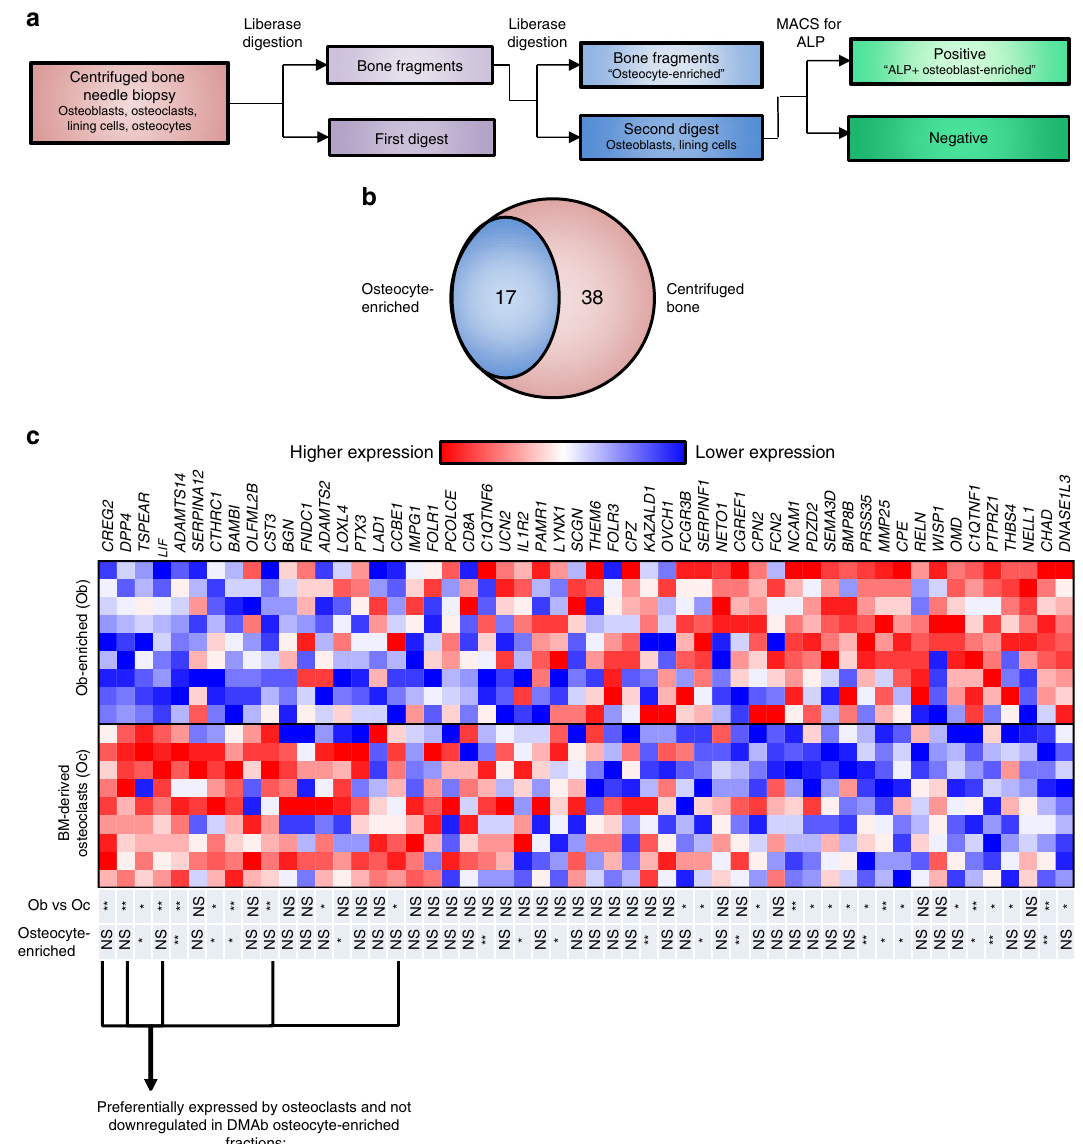
Fig. 3 Identi fi cation of osteoclast-derived secreted factors involved in coupling. a Flow chart describing processing of the bone biopsy samples to select for osteocyte- and osteoblast-enriched fractions. b Overlap of DMAb-suppressed secreted factor genes in centrifuged bone vs. the osteocyte-enriched fraction ( N = 15 participant biopsies/group). For both sample sets, differential gene expression was determined using the R package edgeR. Ingenuity Pathway Analysis was used to identify differentially expressed secreted genes. c Heat map comparison of gene expression in osteoblast-enriched vs. bone marrow-derived osteoclast cultures. Red denotes higher expression and blue denotes lower expression. The Wilcoxon ’ s signed-rank test was used to determine signi fi cance between osteoblast-enriched (Ob) and bone marrow-derived osteoclast (Oc) gene expression. * P < 0.05; ** p < 0.01; NS not signi fi cant. Signi fi cance between osteoblast-enriched (Ob) and osteoclast (Oc) gene expression is shown in the Ob vs. Oc column ( N = 9 participant samples/group). Signi fi cant change in osteocyte gene expression by DMAb compared to placebo is shown in the osteocyte-enriched column ( N = 15 participant biopsies/group); differential expression of RNA-sequencing osteocyte data was performed with the R program edgeR. Source data are provided as a Source Data fi 12 months ( p = 0.07, p = 0.14, respectively; ANCOVA and D-alone group ( p < 0.01; ANCOVA and Bonferonni) over Bonferonni), the decrease was numerically greater in the DMAb 12 months. The change in BMI did not differ in the bispho- group (Fig. 5b). The change in BMI differed among the three sphonate group and the calcium and vitamin D-alone group over groups both over the fi rst 6 months ( p < 0.05) and over 12 months the fi rst 6 months ( p = 0.09) or over 12 months ( p = 0.16; ( p < 0.001, Fig. 5c; ANCOVA and Bonferonni). This was due to a ANCOVA and Bonferonni). Importantly, the change in HbA1c greater decrease in BMI in the DMAb group than in the levels in DMAb-treated patients remained signi fi cant after bisphosphonate group ( p < 0.01) over the fi rst 6 months and to a adjustment for changes in BMI (Supplementary Table 7). Thus, greater decrease in BMI in the DMAb group than in either the this clinical study demonstrated an improvement in glycemic bisphosphonate group ( p < 0.0001) or the calcium plus vitamin control in type 2 diabetic or prediabetic patients with